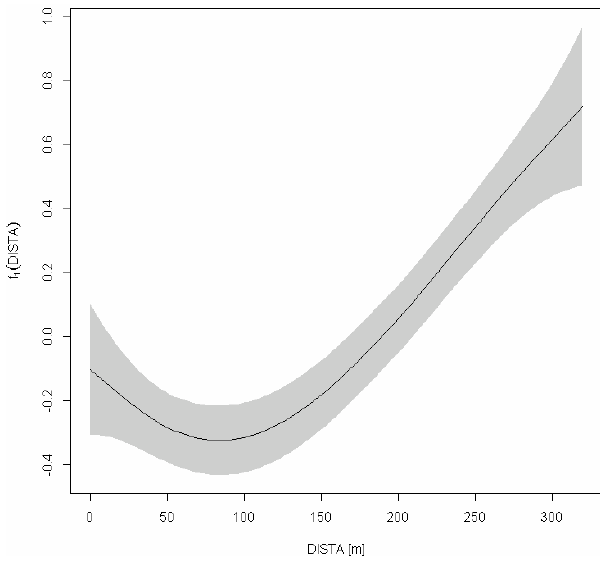
Figure 3 1097 Fig. 3. Nonlinear effect of a vegetation square’s distance from grid- row A (DISTA) on the local relief energy (RELEN) (see Eq. 9). Shaded: 95%-confidence